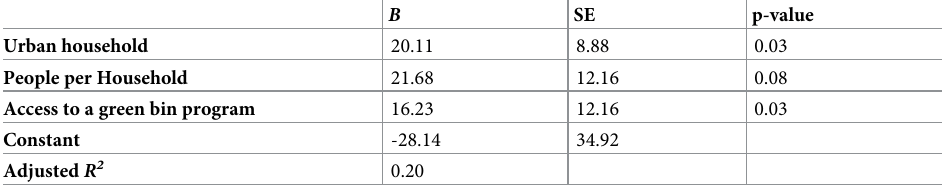
Table 3. Multiple regression on spring food waste disposal (kg/household/week). B SE